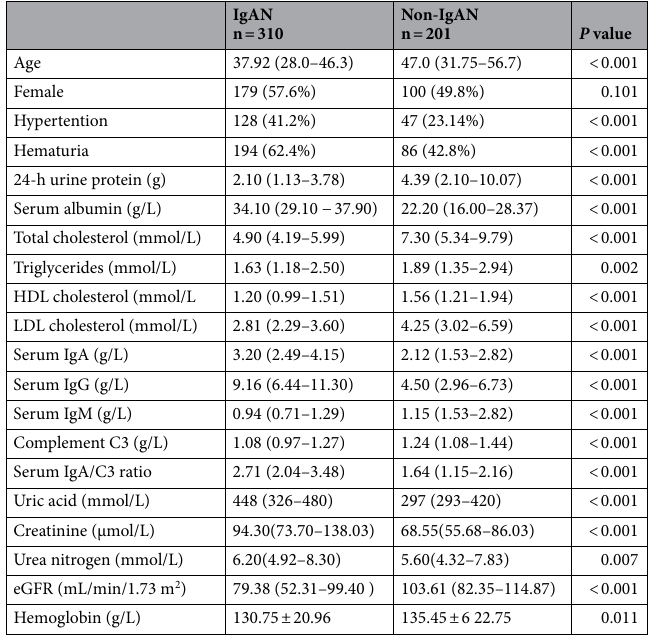
Table 2. Differences in the clinical parameters between IgAN and non-IgAN in the training set. IgA: immunoglobulin A; IgG: immunoglobulin G; IgM: immunoglobulin M; eGFR: estimated glomerular filtration rate.